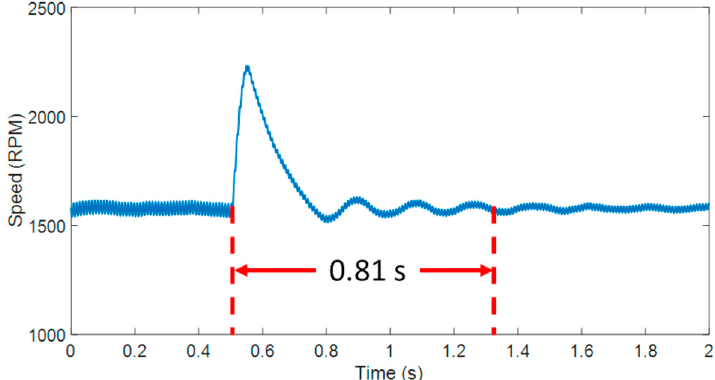
Figure 25. Dynamic response of conventional SVM-DTC.